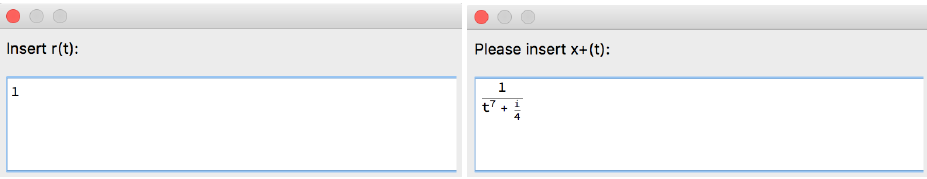
Figure 61. Output given by the [SInt] 2.0 algorithm.